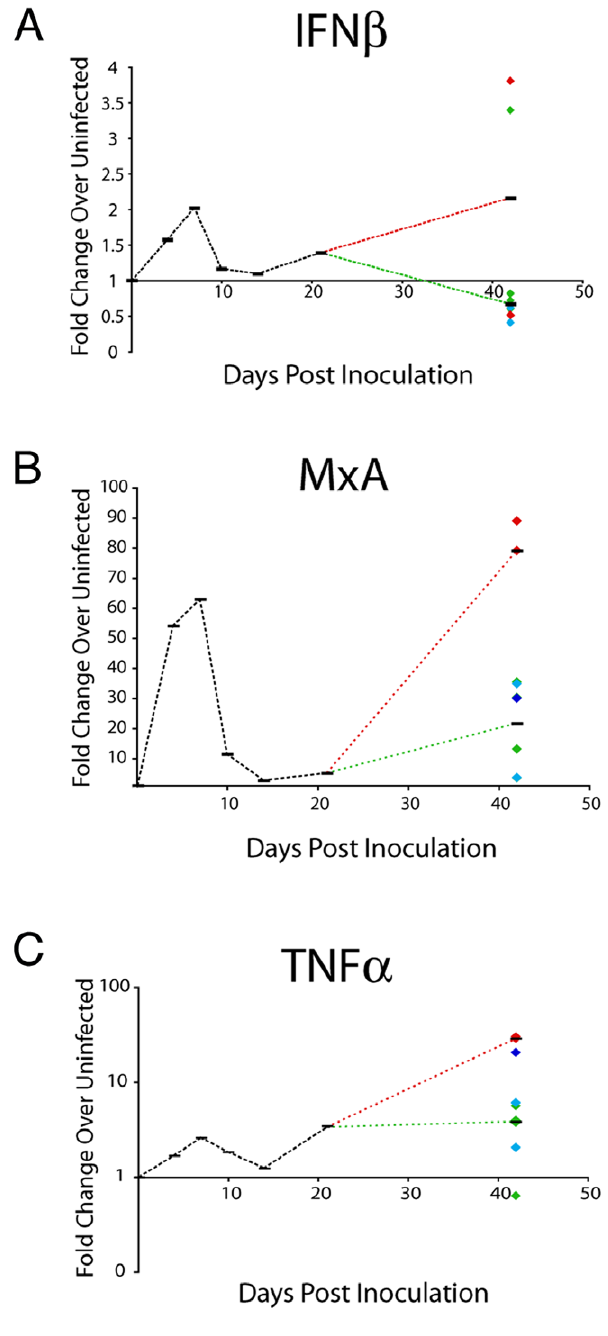
Figure 3. Quantitation of mRNA in brain of SIV-infected macaques. A) IFN b ; B) MxA; and C) TNF a mRNA was isolated from brain of uninfected and SIV-infected macaques at terminal time points (4, 7, 10, 14, 21, or 42 days after inoculation) and mRNA levels quantitated by quantitative RT-PCR. mRNA levels in the SIV-infected brain are represented as fold change over the average of three uninfected brain RNAs, calculated by DD Ct. Medians (black bars) for each experimental group are indicated. For the 42-day group, each diamond represents one animal, color-coded according to CNS disease severity (red-severe; blue-moderate; turquoise-mild; green-none), and the black bars represent the medians for severe/moderate (red dotted line), and mild/none animals (green dotted line). Outliers whose values were higher than 5 times the standard deviation for each group were excluded.